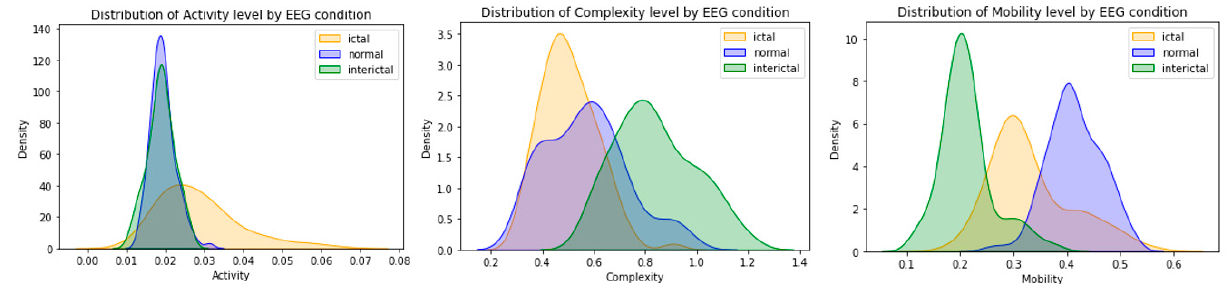
Figure 11 . Distribution of each feature calculation result shows the different characteristics from each EEG signal class.